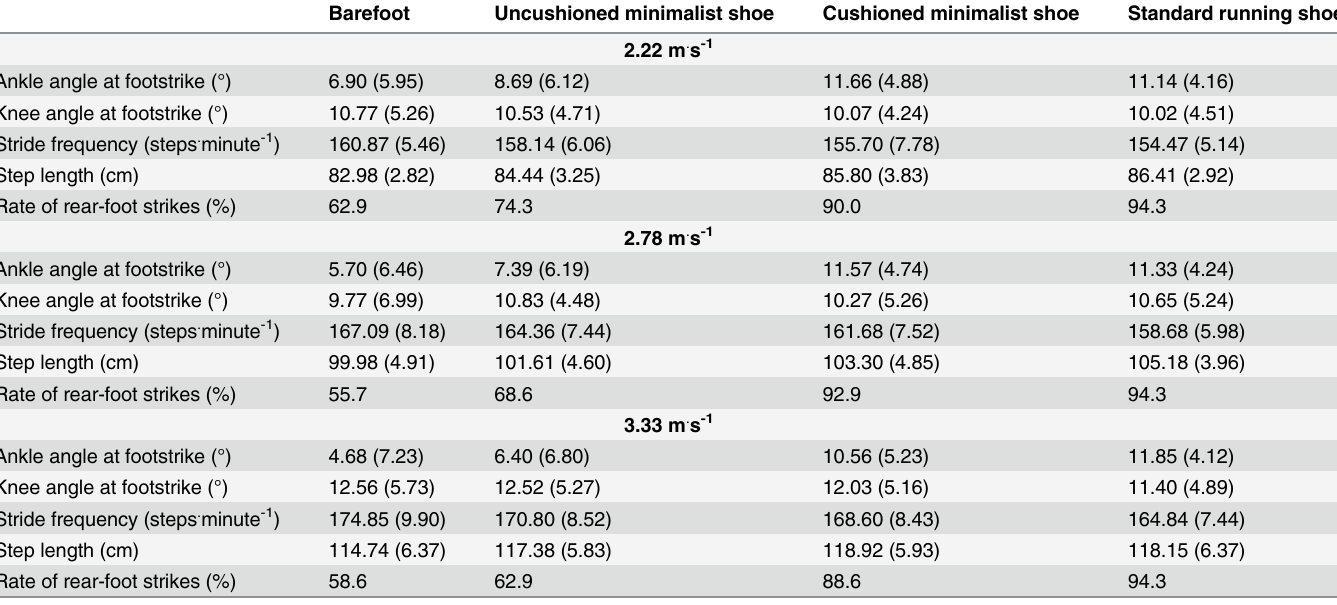
Table 1. Group mean (SD) temporal-spatial and kinematic parameters for 2.22, 2.78 and 3.33 m . s -1 .